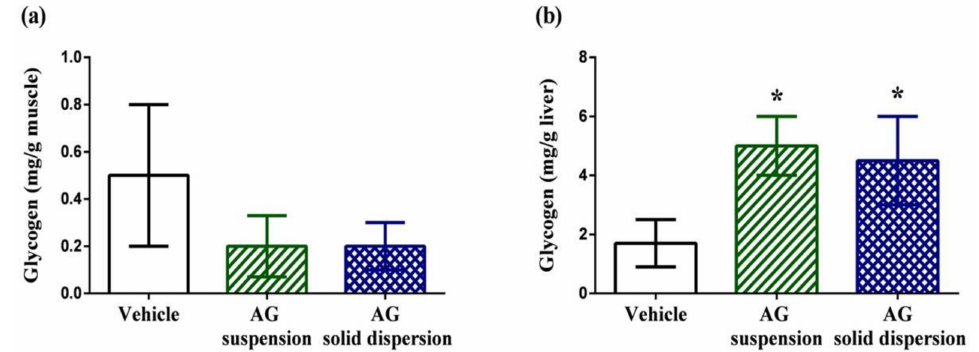
Figure 10. E ff ect of andrographolide (AG) on: glycogen content in: ( a ) muscle; and ( b ) liver. Data are expressed as mean ± standard deviation ( n = 5 for each group). * Indicates significant di ff erence compared to vehicle group ( p <